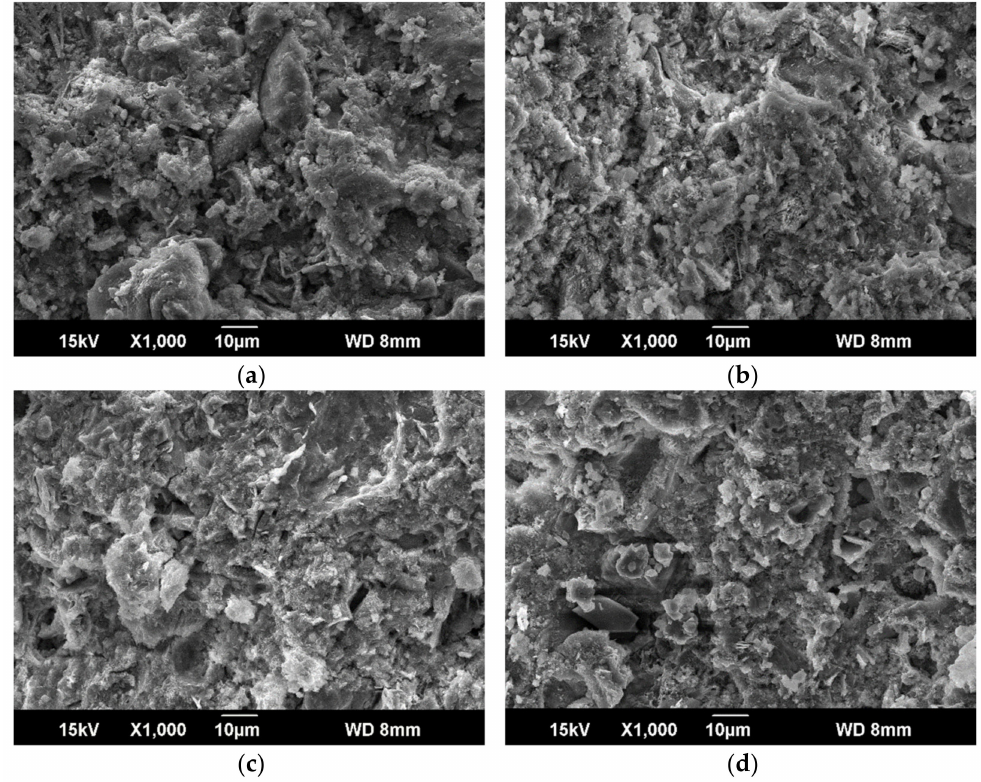
Figure 11. SEM of grout with different amount of ER. ( a ) e-1; ( b ) e-2; ( c ) e-3; ( d ) e-4.